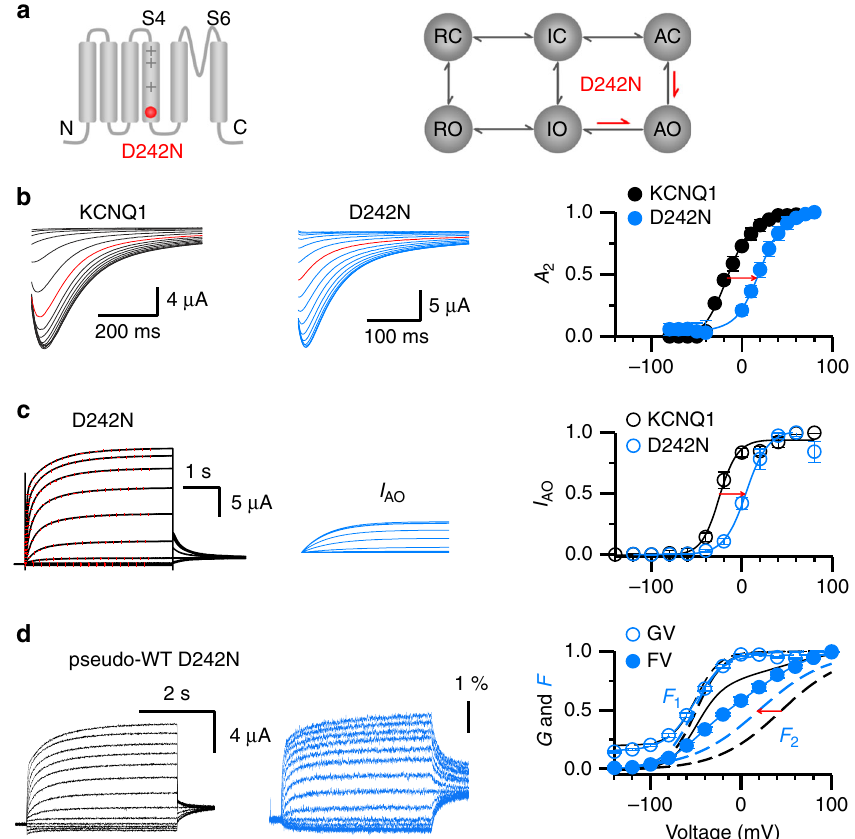
Fig. 5 D242N shifts the voltage dependence of the AO state and hook currents. a Schemes showing that the D242N mutation shifted the voltage- dependent transitions of the AO state and the VSD-pore coupling in the AO state. b Left, the hook currents of KCNQ1 (black) and D242N (blue) recorded at − 120 mV in 100 mM K + solution, with pre-pulse voltages ranging from − 80 mV to +80 mV. Currents at − 20 mV are shown in red for comparison. Right, hook current ( A 2 ) voltage dependences of WT KCNQ1 (black) and D242N (blue). c Left, D242N currents (left, black lines) responding to voltages from − 120 to 80 mV are fi tted with a double exponential function (red dots), and the currents of the AO state ( I AO ) are shown in blue (middle). Right, voltage dependence of the AO state in WT KCNQ1 (black) and D242N (blue). d VCF recordings of D242N currents (black) and fl uorescence (red). Right panel, the G – V (blue open circle) and F – V (blue solid circle) relationships of D242N with the F F G – V (black short dashed 1 and 2 components (dotted blue lines). The line) and F – V (black line) relationships with the F 1 and F 2 components (dotted black lines) of the pseudo-WT KCNQ1 are shown in black for comparison. n ≥ 4. Error bars are the